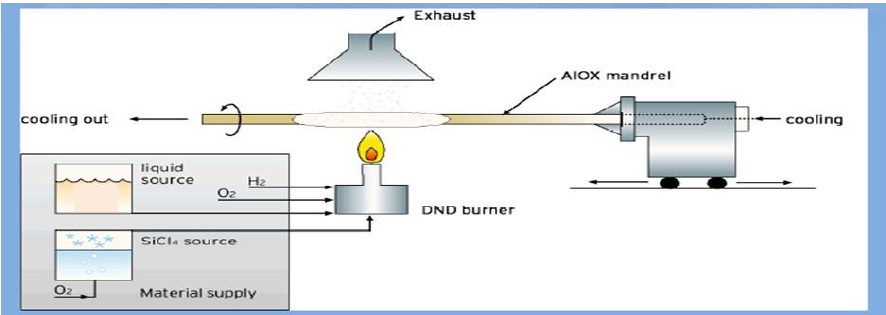
Figure 2. Schematic of the direct nanoparticles deposition (DND) process.